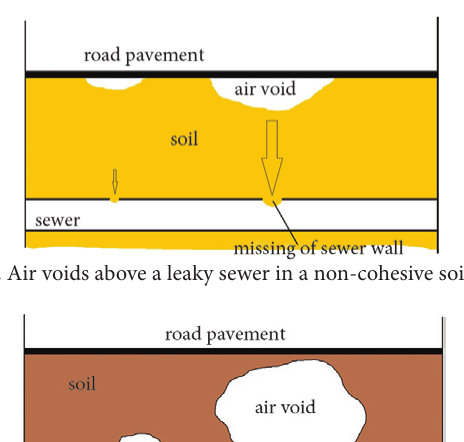
Fig. 8. Infiltration of groundwater into the sewer